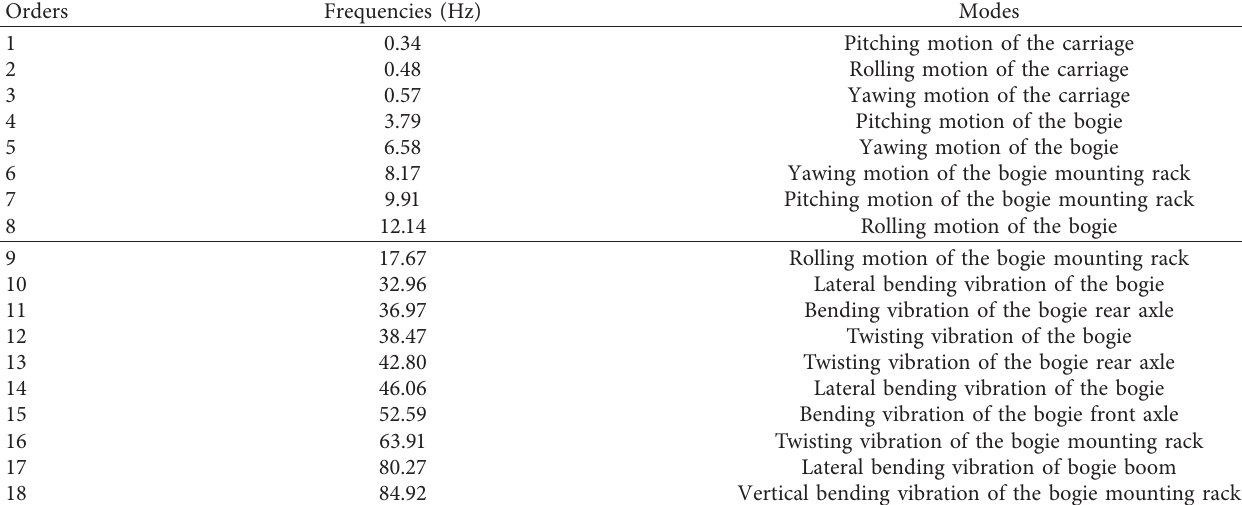
Figure 1: Structures of the (a) vehicle and (b) bogie as well as (c) attitude Table 1: Natural frequencies of the system.